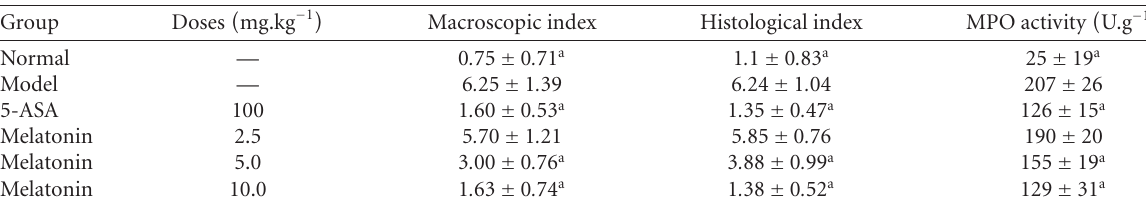
Table 1. E ff ects of melatonin and 5-ASA on the macroscopical and histological damage indices and MPO activity in rats ( x ± s n = 10). a denotes that P < . 01 versus the model group.